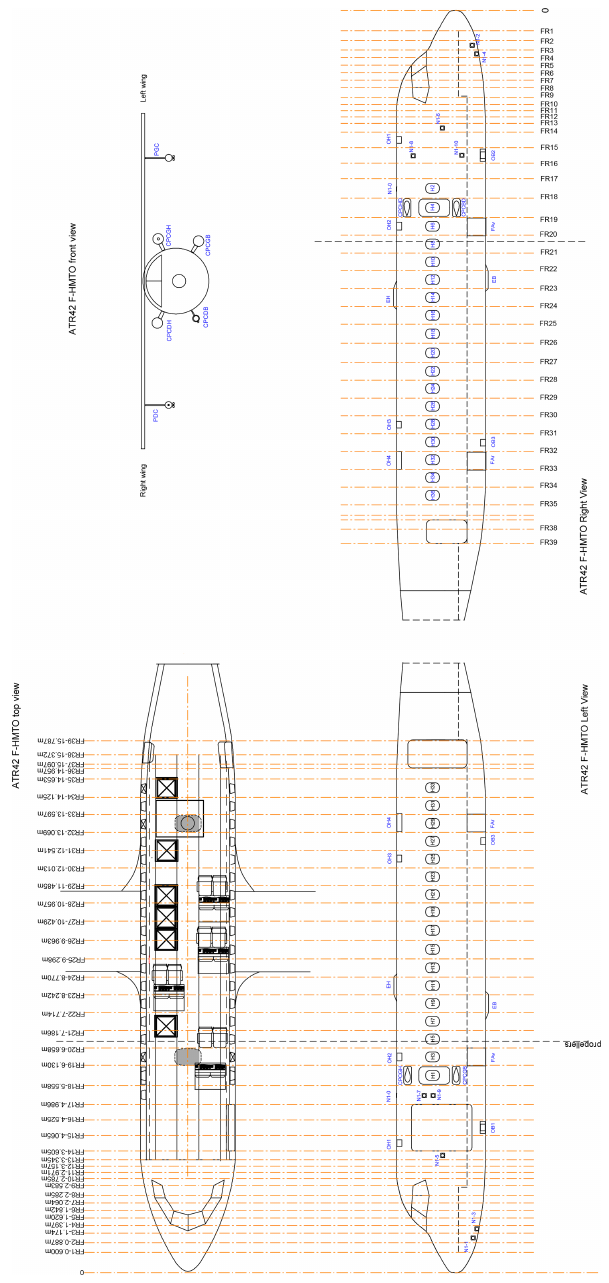
Figure D1. Instrumental configuration of the ATR showing the nomenclature used in Tables 5 to